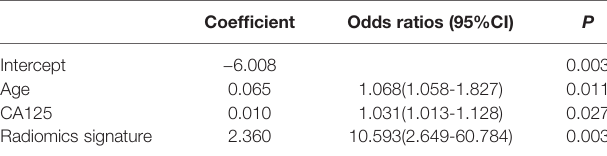
TABLE 4 | Results of the Multivariable Logistic Regression.